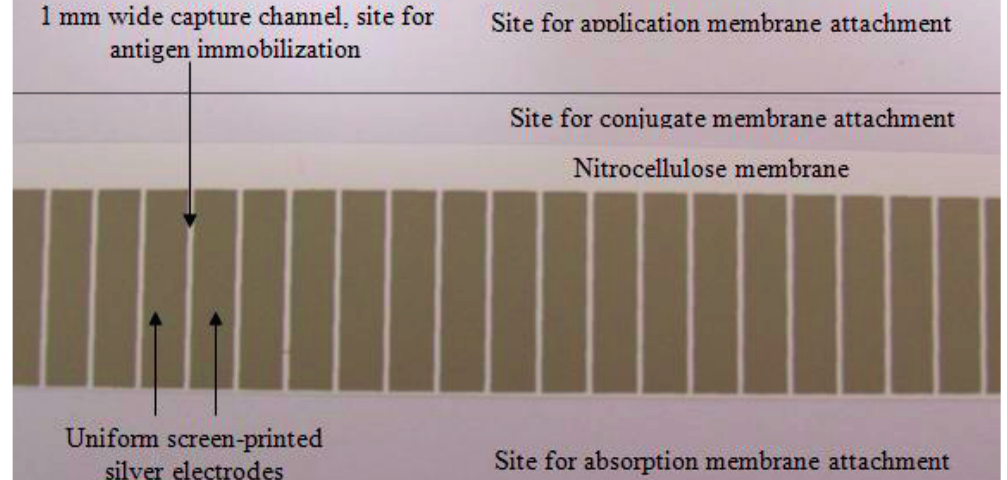
Figure 1. Screen-printed silver electrode films on the capture membrane before immunosensor assembly and